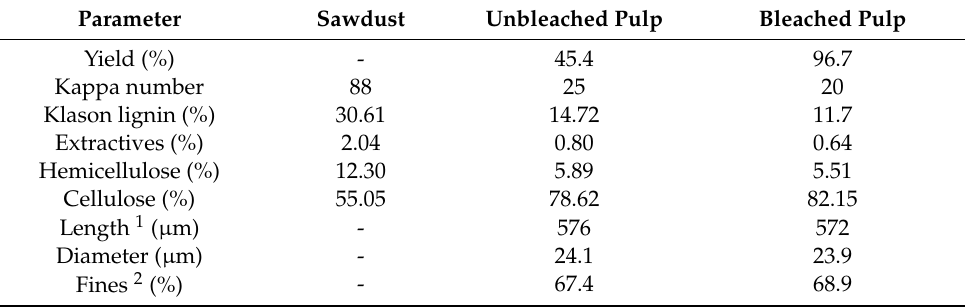
Table 1. Chemical and morphological analysis of the raw material and pulps.